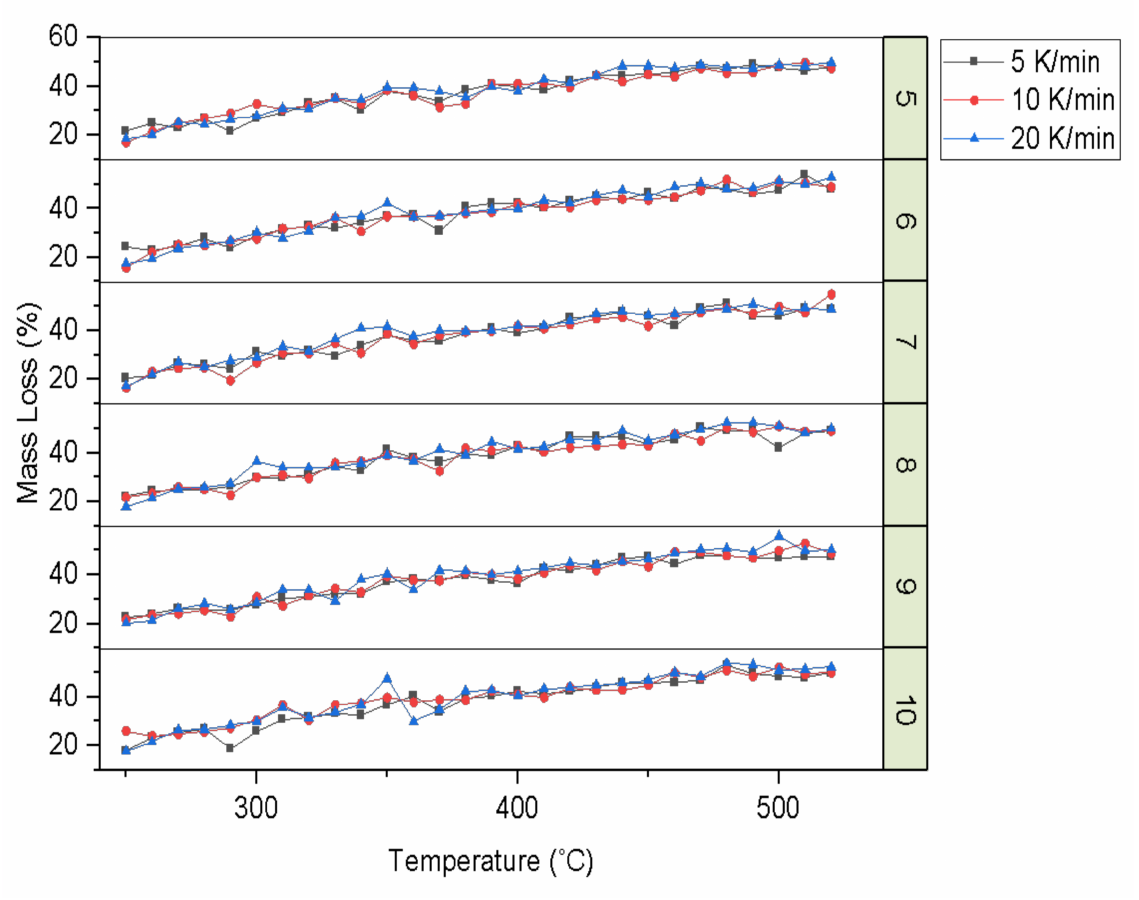
Figure 8. Mass losses of sewage sludge at several temperatures of 250–500 ◦ C, residential time and heating